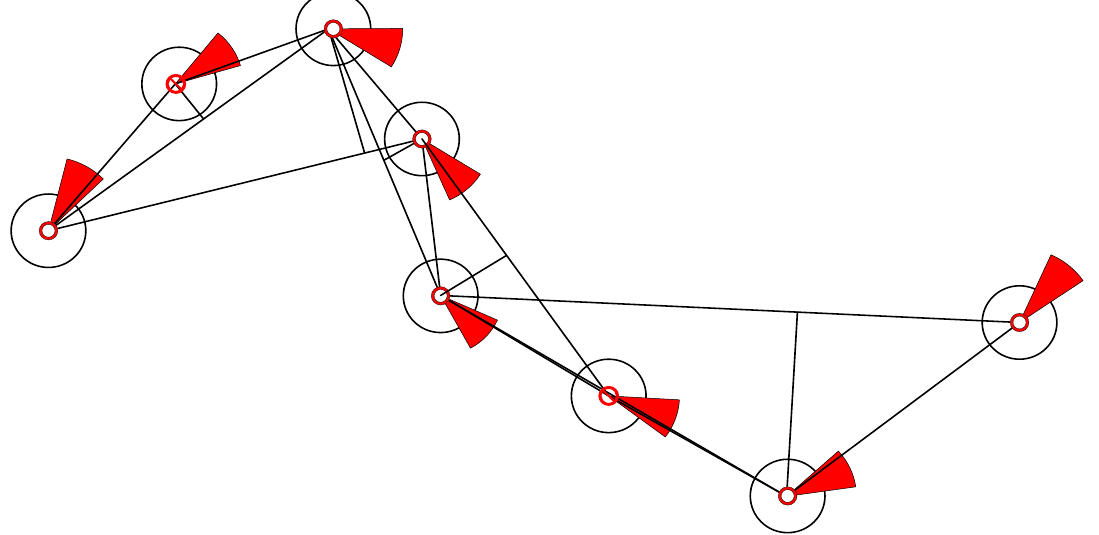
Figure 11. Improved sliding-window compression algorithm.